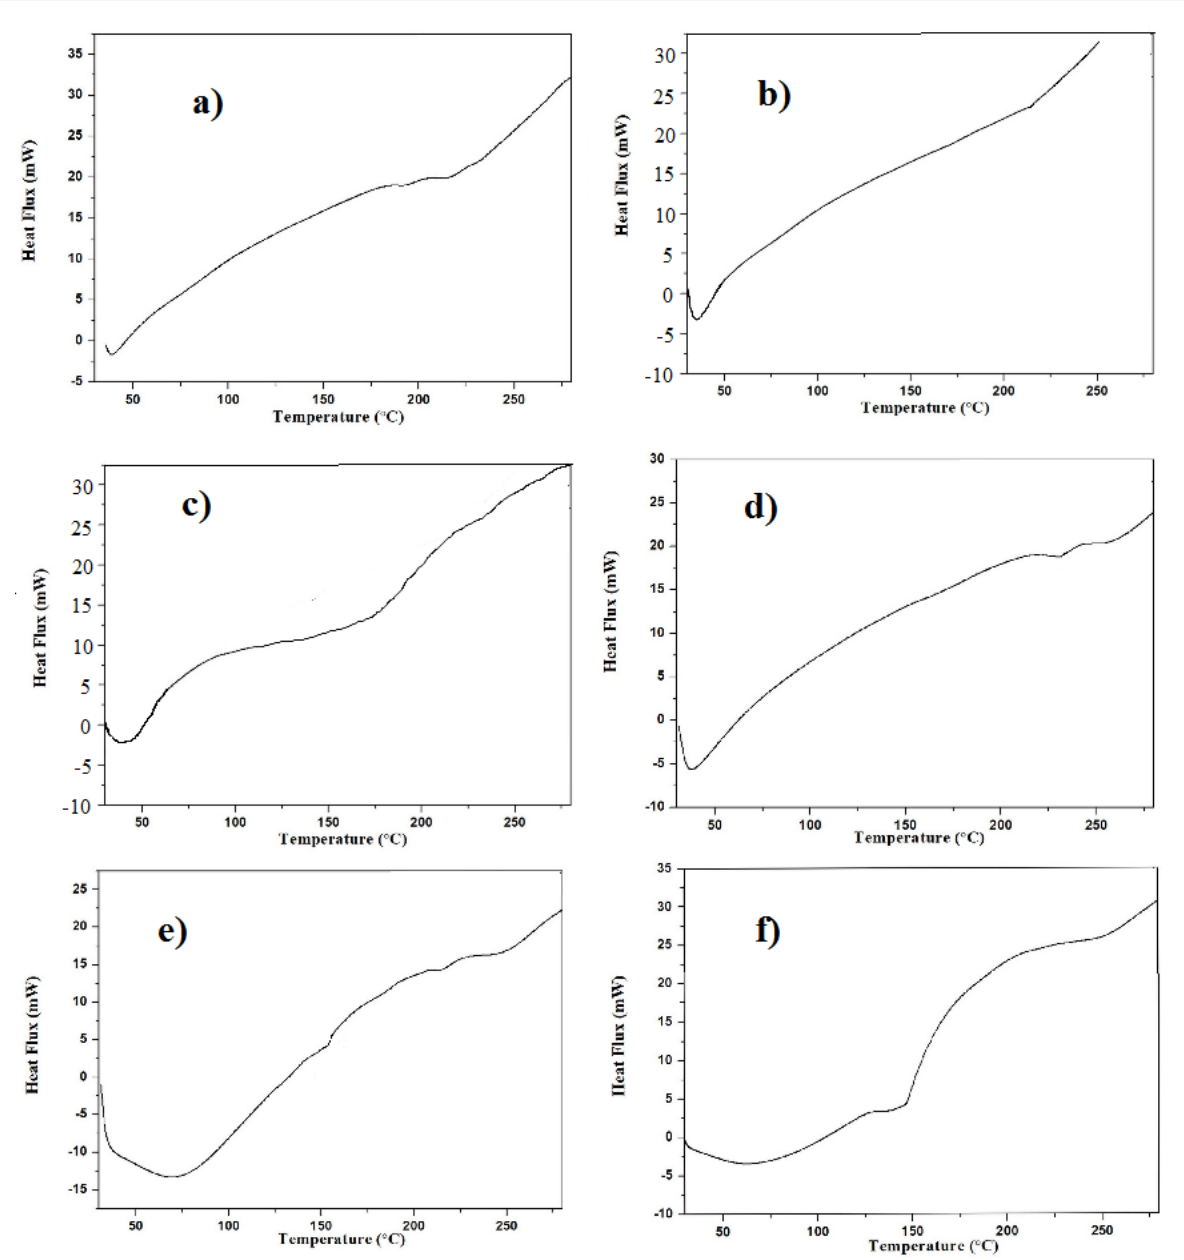
FIGURE 6.1 - Differential scanning calorimetry study of a) OND-PVP K-30 1:1 w/w SD; b) OND-PVP K-30 1:3 w/w SD; c) OND-PVP K-30 1:5 w/w SD; d) OND-HPβCD 1:1 w/w SD; e) OND-HPβCD 1:3 w/w SD; f) OND-HPβCD 1:5 w/w